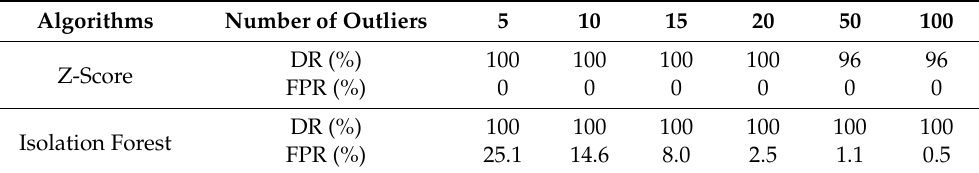
Table 2. Comparison of different novelty detection algorithms.